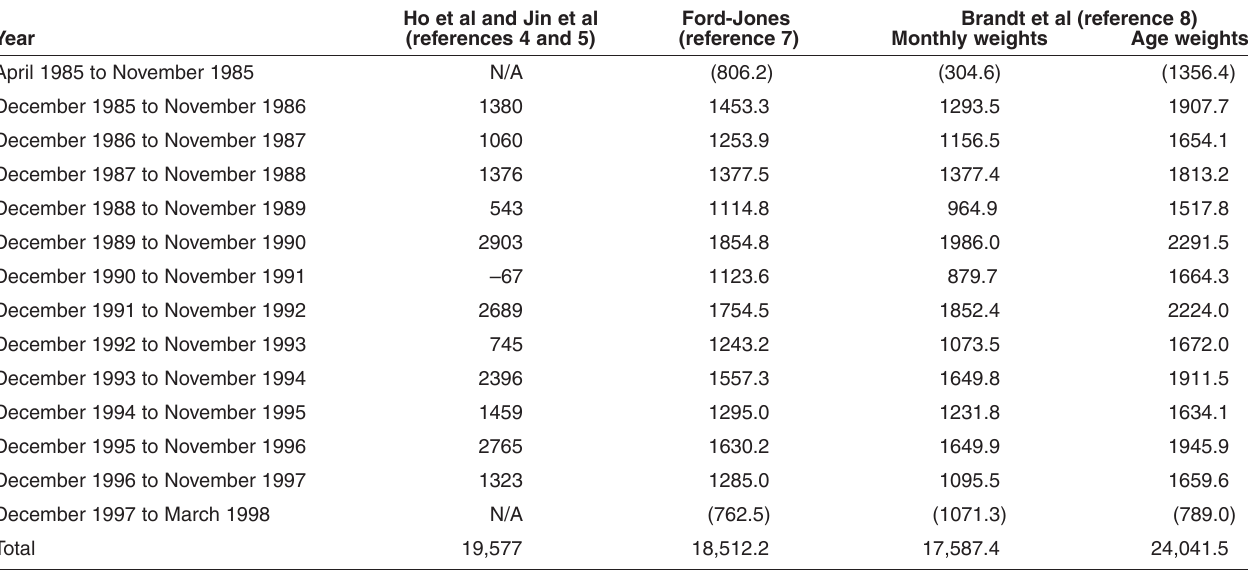
TABLE 5 Methods of comparing rotavirus-associated diarrhea hospitalizations among children younger than five years of age, Quebec, April 1, 1985 to March 31,